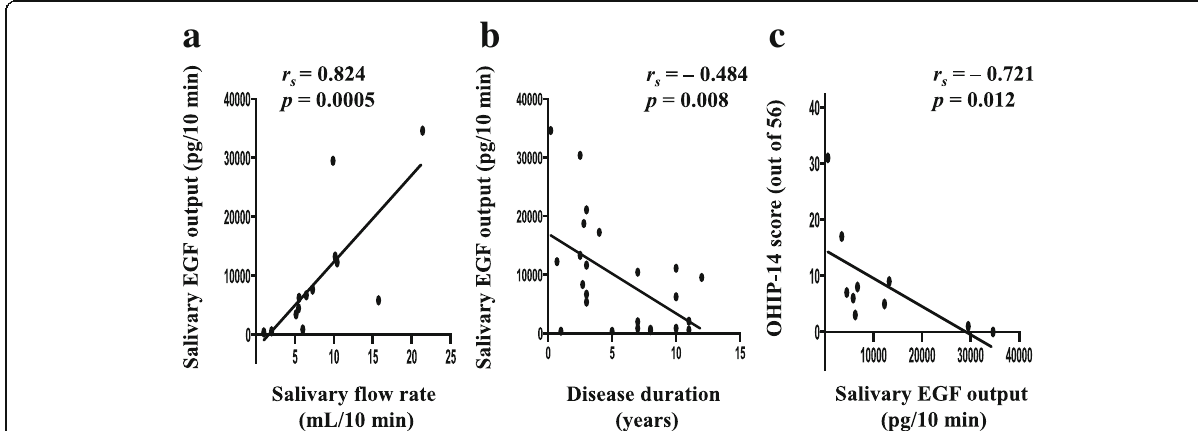
Fig. 2 Correlations between different factors and salivary epidermal growth factor (EGF) output in the Sjögren ’ s syndrome (SS) group. a Correlation of salivary flow rate with salivary EGF output ( n =13). b Correlation of disease duration with salivary EGF output ( n =24). c Correlation of the Oral Health Impact Profile (OHIP)-14 score with salivary EGF output ( n =10). Correlations were assessed using Spearman ’ s rank correlation